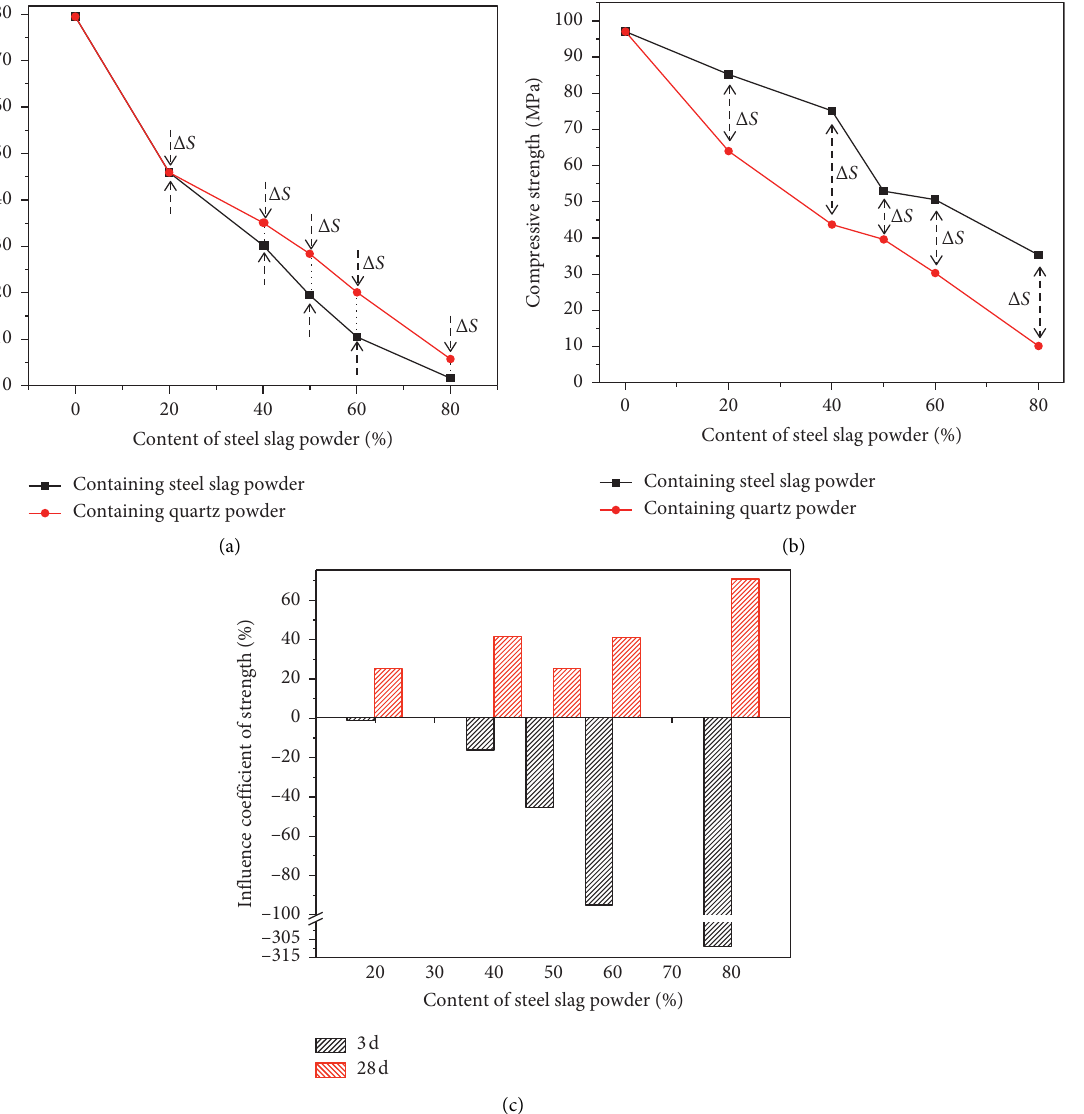
Figure 7: Influence coefficient of steel slag powder on compressive strength of blended cement. (a) 3d. (b) 28d. (c) Influence coefficient of